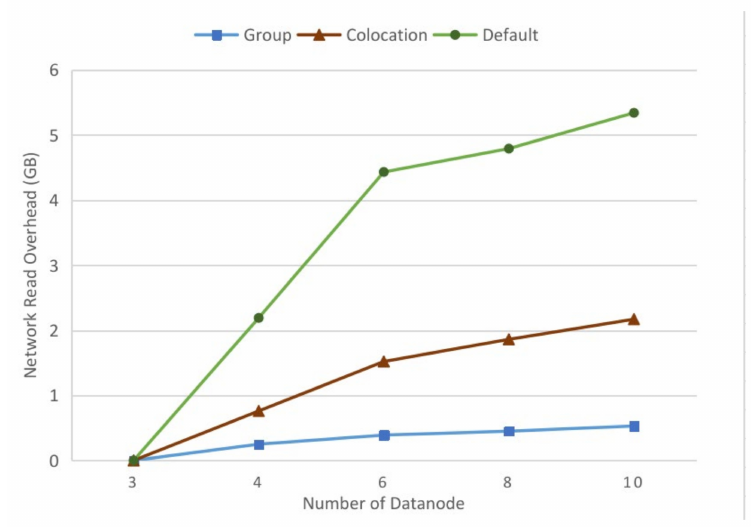
Figure 7. IO performance of the group-based method, the colocation-based method, and the default Hadoop replica placement policy with different numbers of the cluster